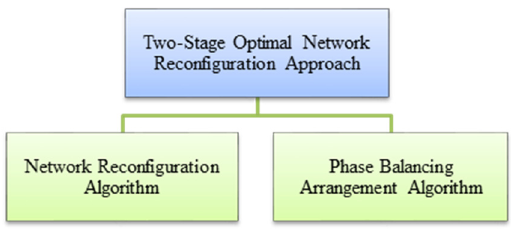
Figure 2. The schematic diagram of the proposed